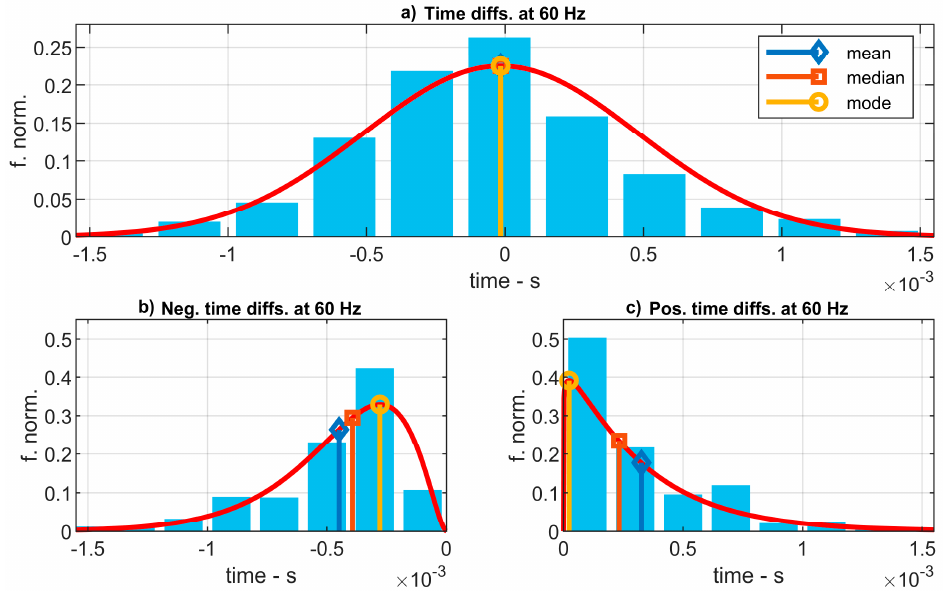
Figure 11. Relative time deviation for the different sensors’ arrangements at different frequencies of the sound wave. ( a ): Lower amplitude signals. ( b ) Higher amplitude signals.